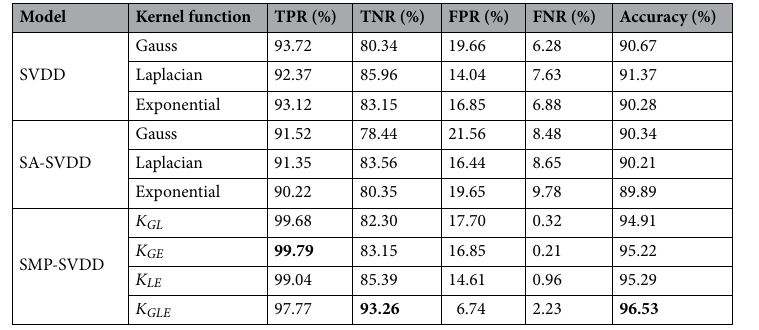
Table 3. Comparison of outlier detection indexes of pitch angle deviation in the whole guidance stage. Significant values are in bold.